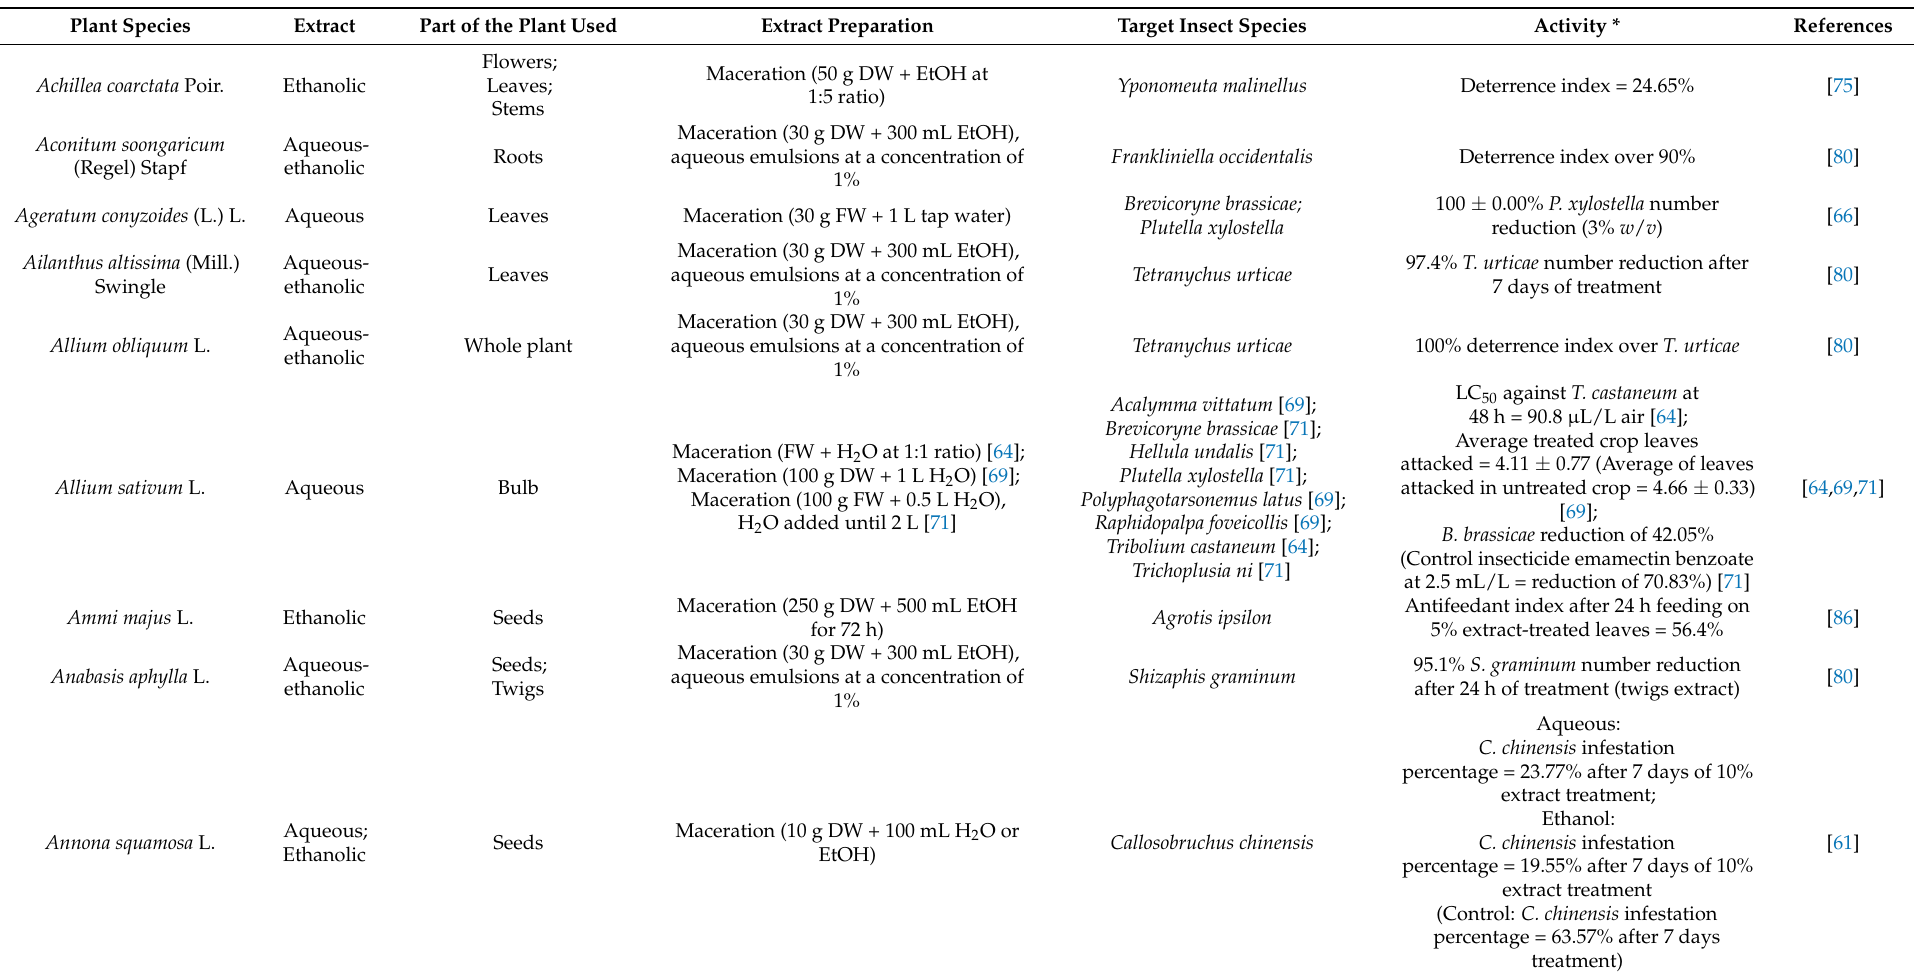
Table 1. Plant species mentioned in literature with potential to be effective bio-insecticides, according to their aqueous and/or ethanolic extracts pesticide properties. Plant